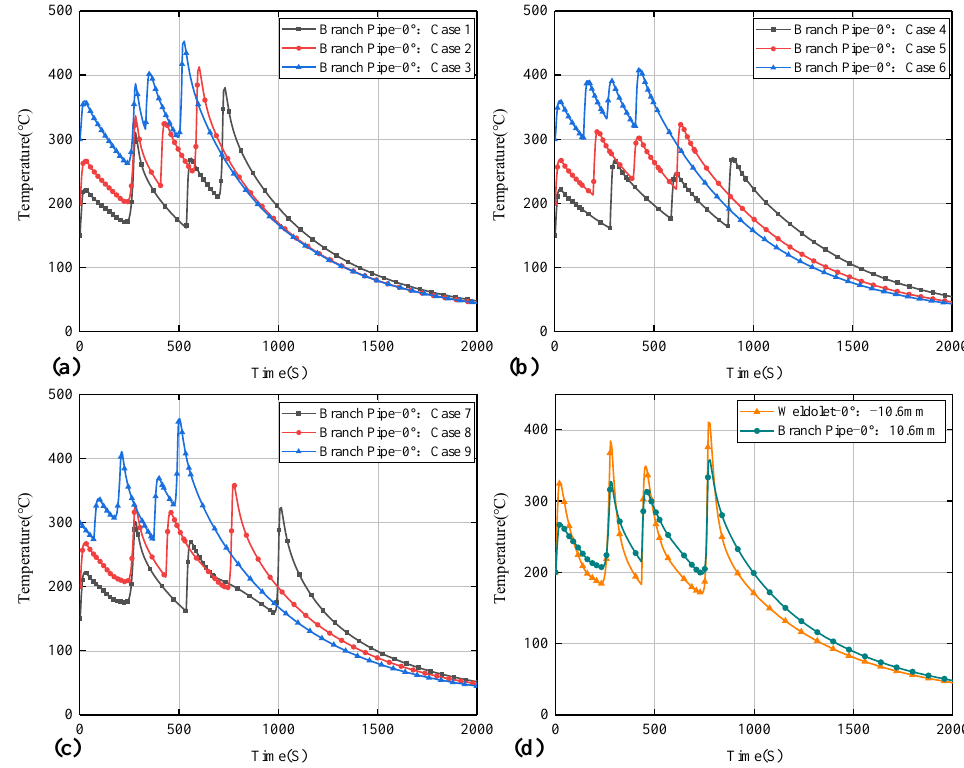
Figure 12. Temperature history curve ( a ) Case 1 – 3 ( b ) Case 4 – 6 ( c ) Case 7 – 9 ( d ) Thermal cycle comparison between the weldolet-side node and the branch-side node. Figure 12a – c respectively show the temperature distribution on the outer surface of dissimilar steel joints at 0° section under nine different welding cases (Case 1 – Case 9). It can be observed that all thermal cycling curves have four peaks and troughs, which is due to the fact that the 0° position is both the weld start and weld end point in the three weld- ing sequences. Due to the difference in temperature between welding layers, the peak temperature and the trough temperature are kept within a specific temperature range.